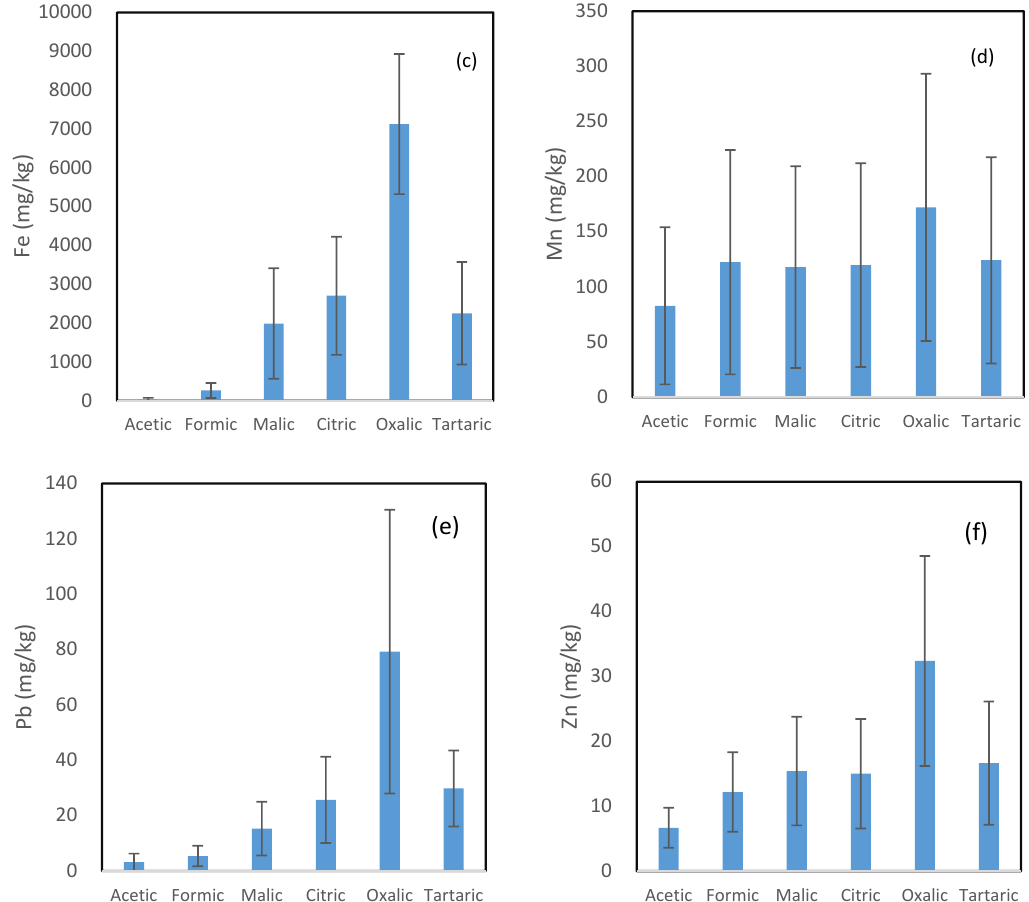
Figure 1. Mean concentration of ( a ) arsenic; ( b ) copper; ( c ) iron; ( d ) manganese; ( e ) lead; and ( f ) zinc being released from the soils by the six organic acids.